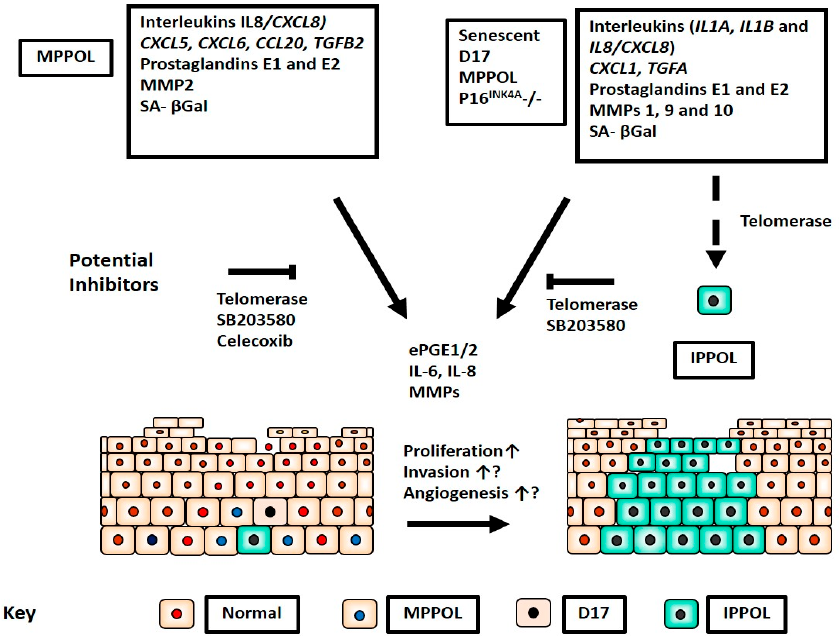
Figure 11. Summary of ePGE and SASP regulation in PPOL keratinocytes, their potential